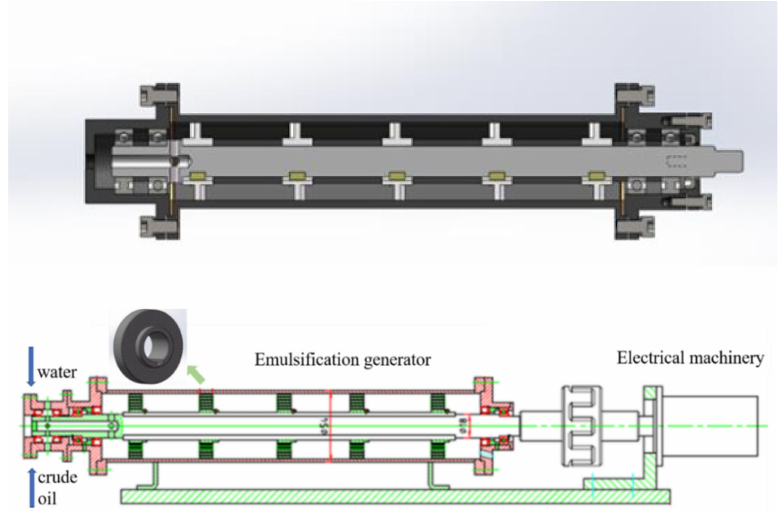
Figure 2. Physical map and schematic diagram of the sieve plate rotary emulsification